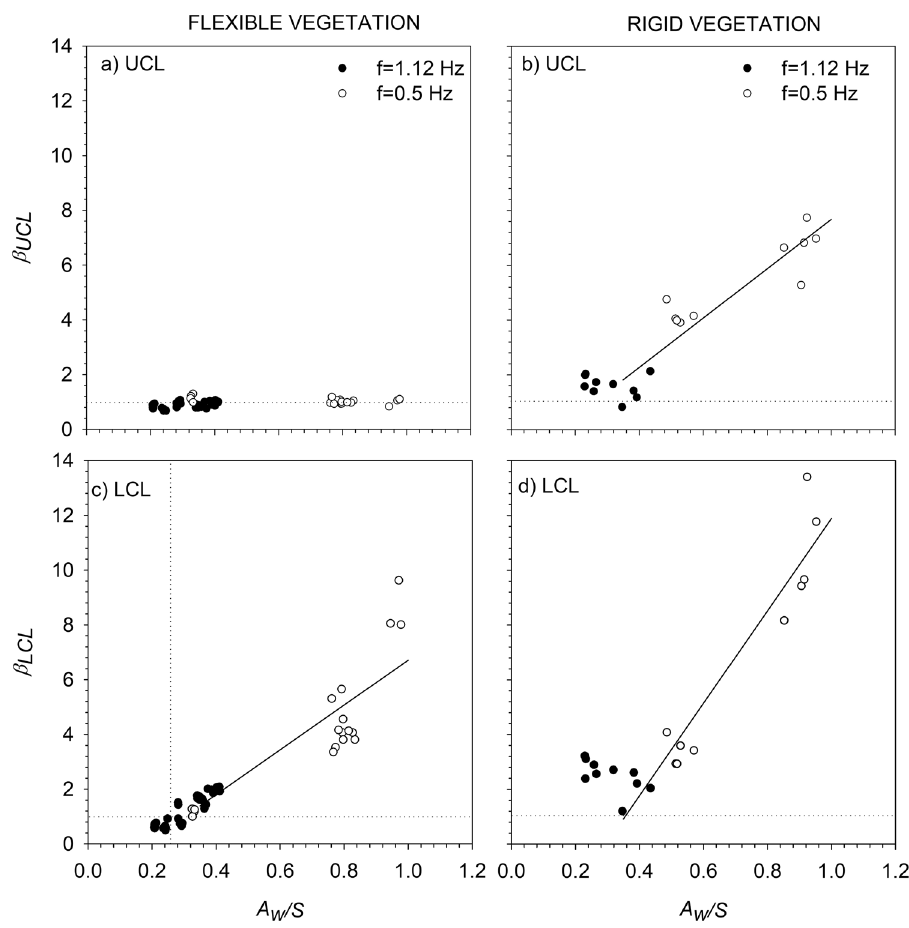
Figure 2. TKE attenuation in relation to the non-vegetated cases at the UCL ( β UCL ) for ( a ) flexible vegetation ( a ) and for ( b ) rigid vegetation ( b ). TKE attenuation in relation to the non-vegetated cases at the LCL ( β LCL ) for ( c ) flexible vegetation and for ( d ) rigid vegetation. Unfilled circles correspond to f = 0.5 Hz, and solid black circles to f = 1.12 Hz. Lines correspond to the linear best fit for the cases A w /S > 0.35 when β increased linearly with A w /S , independent of the wave frequency. In the UCL for rigid vegetation, β = 9.02 × A w /S -1.34 ( R 2 = 0.8625, p-value < 0.01). In the LCL for rigid vegetation, β = 16.90 × A w /S -5.00 ( R 2 = 0.9224, p-value < 0.01), and for the flexible vegetation β = 8.19 × A w /S -1.48 ( R 2 = 0.7819, p-value < 0.01). Vertical dashed lines represent the x-axis position where A w /S = 0.35, and horizontal dashed lines correspond to the y-axis position where β =